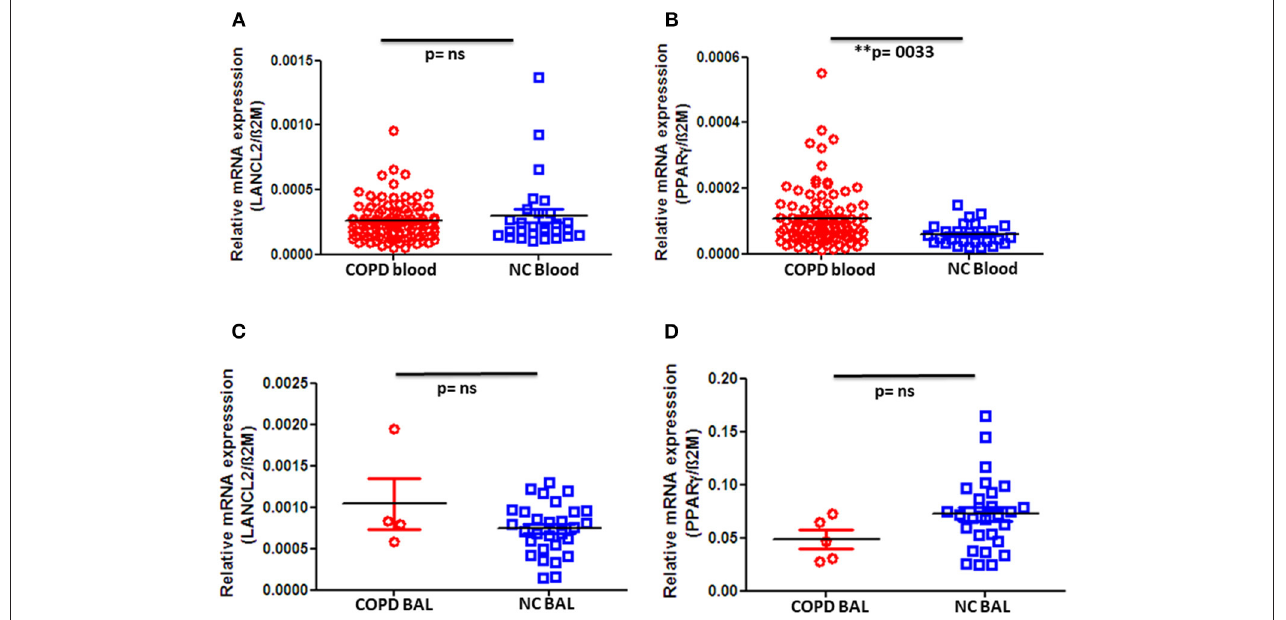
FIGURE 2 | Gene expression levels of LANCL2 and PPAR- γ in patients with COPD and controls. Gene expression levels of (A) LANCL2 and (B) PPAR- γ on peripheral blood cells from COPD patients ( n = 94) and age- and gender-matched controls ( n = 28 and 27, respectively). Bronchioalveolar lavage cell gene expression of (C) LANCL2 ( n = 4) and (D) PPAR- γ ( n = 5) in COPD patients and control subjects ( n = 29 and 28, respectively). The individual dots represent data obtained from individual subjects. Statistical analysis was done by either nonparametric Mann–Whitney test or unpaired Student t -test.